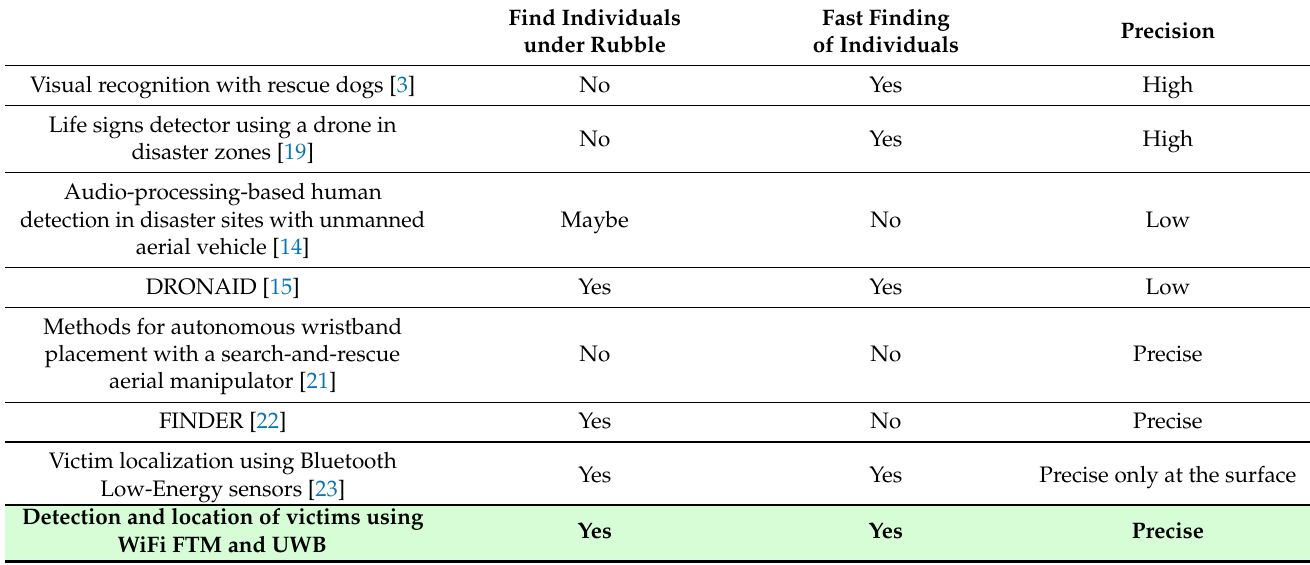
Table 1. Overview of different methods and prototypes for the detection and localization of victims. Find Individuals Fast Finding under Rubble of Individuals